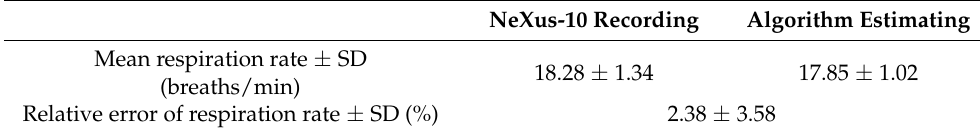
Table 3. ECG-derived respiration algorithm results (healthy participant).